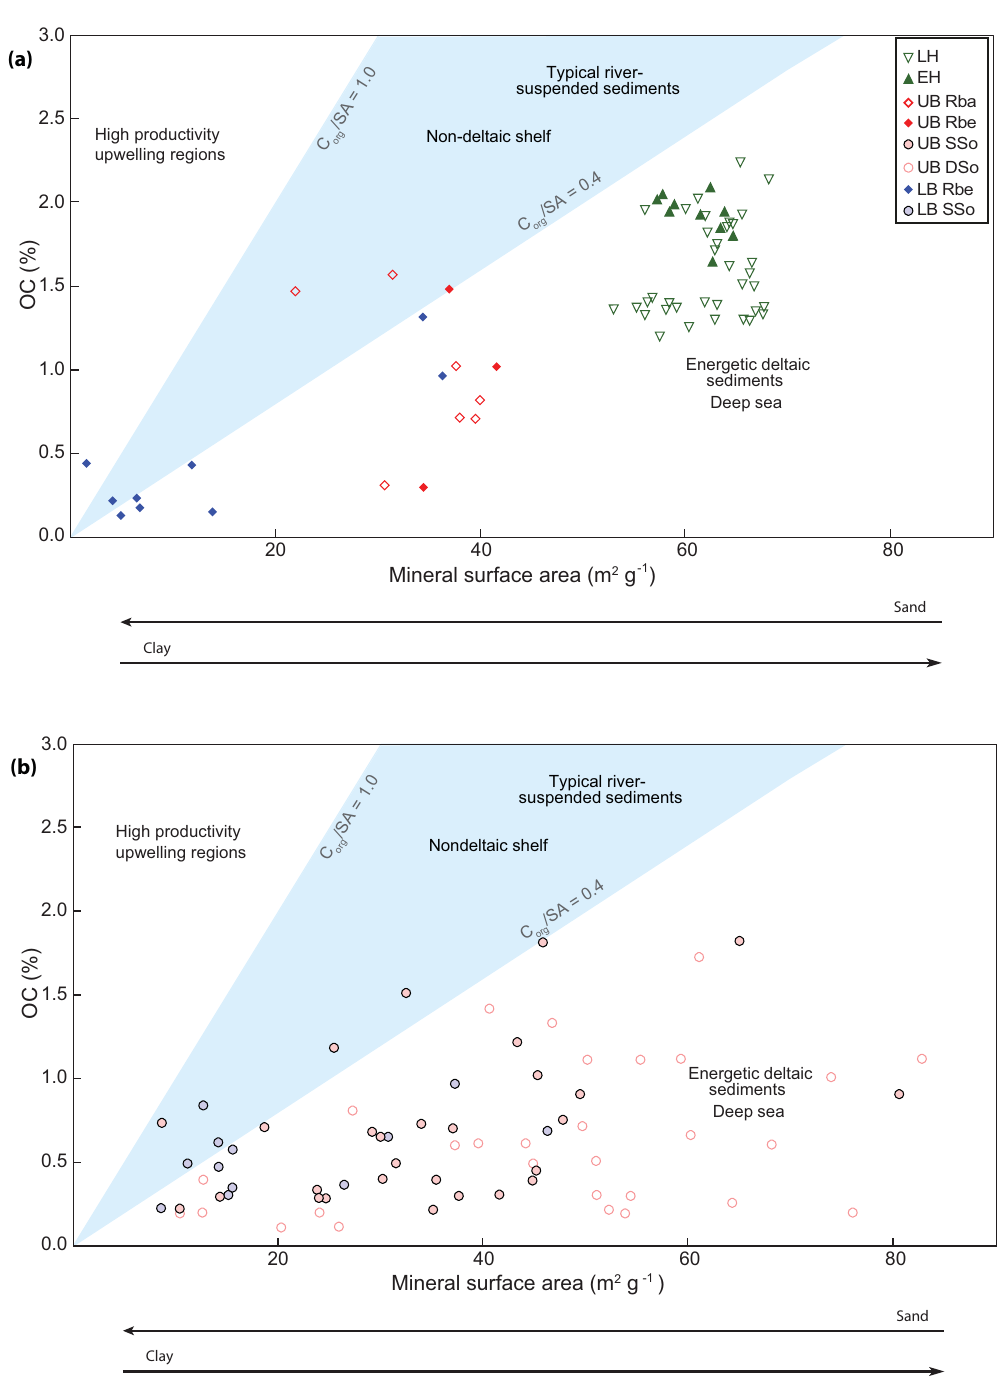
Figure 4. (a) Organic carbon loadings for river sediments and marine sediments. (b) OC vs. MSA for soils samples within the basin. Symbol key and abbreviations are as for Figs. 1 to 3. Blue shaded area corresponds to range typical for river-suspended and non-deltaic sediments as described by Blair and Aller